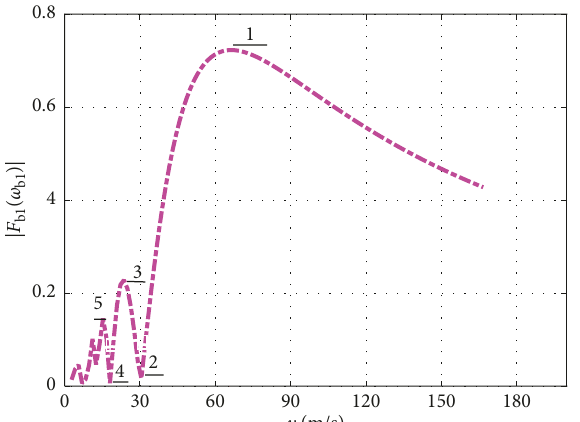
Figure 9: Amplitudes of moving constant load versus different speeds.